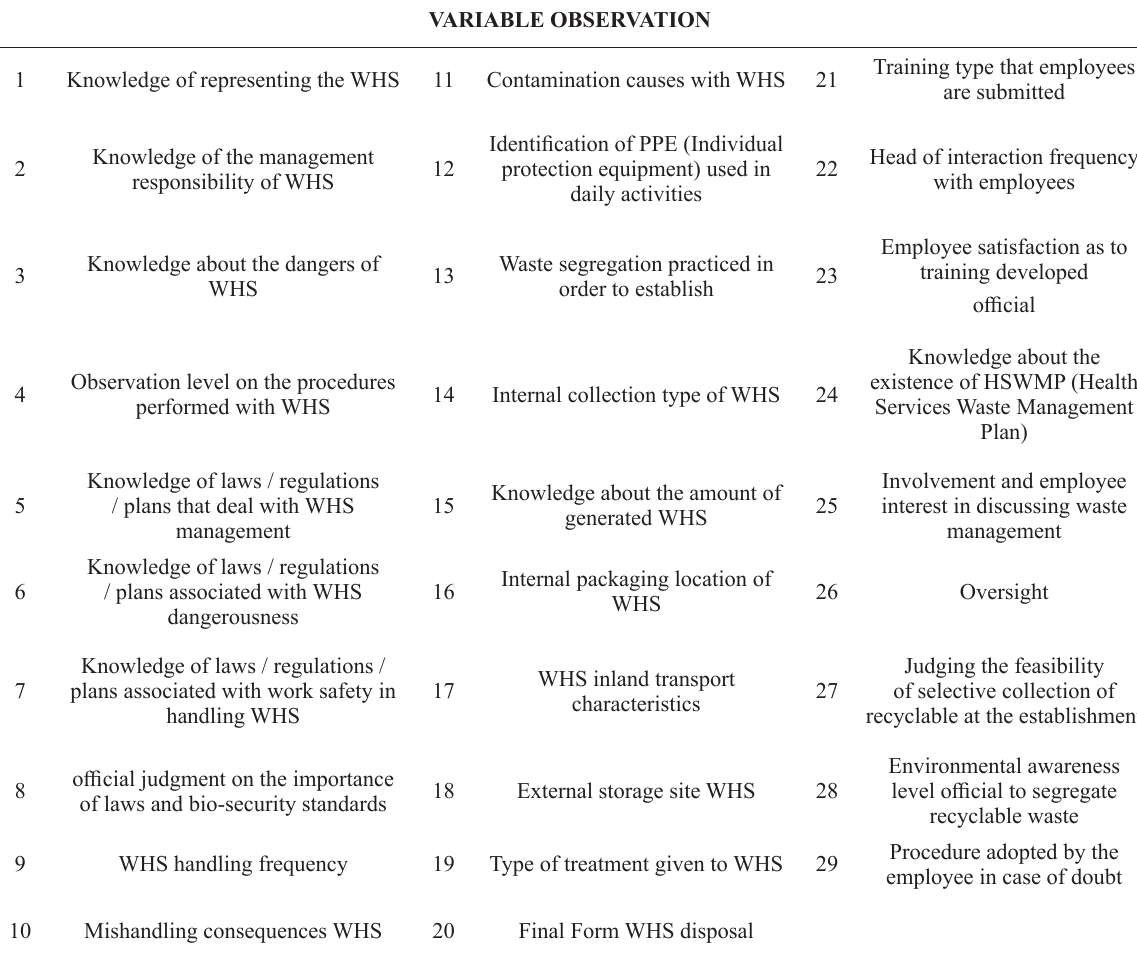
Observation identified